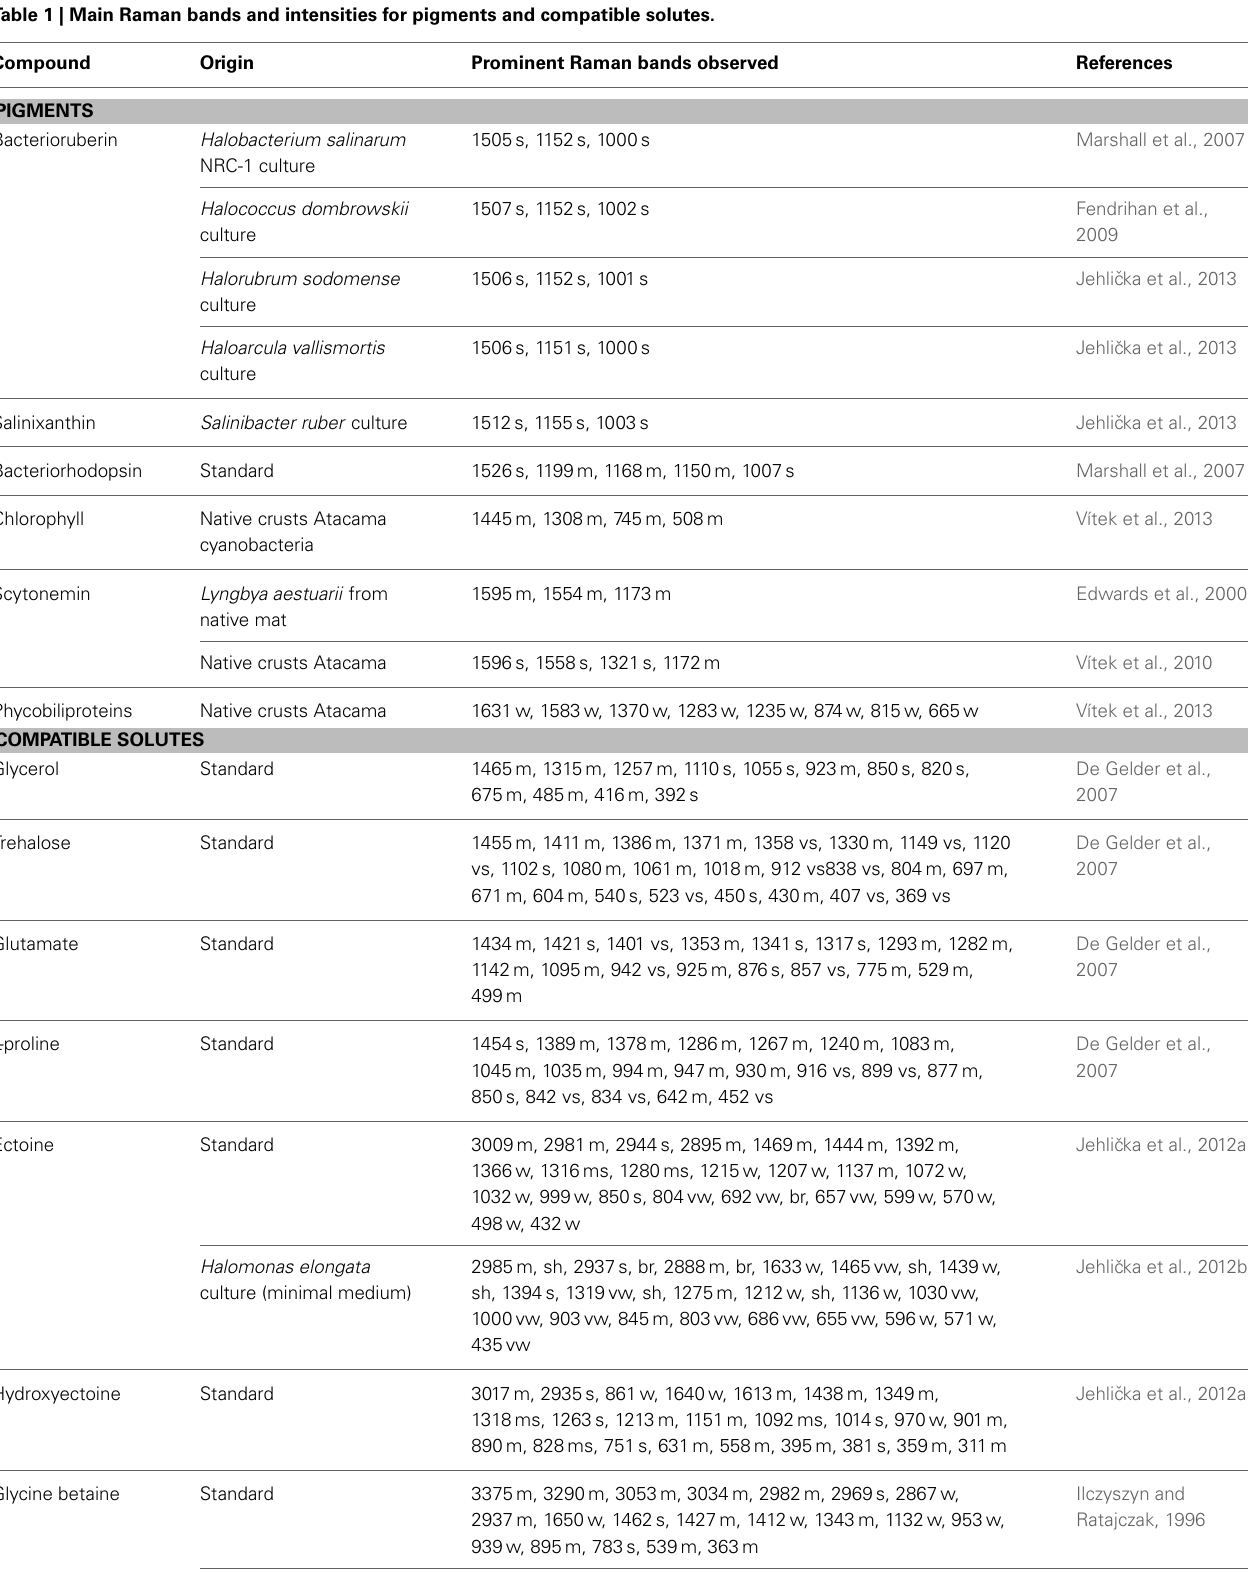
Table 1 | Main Raman bands and intensities for pigments and compatible